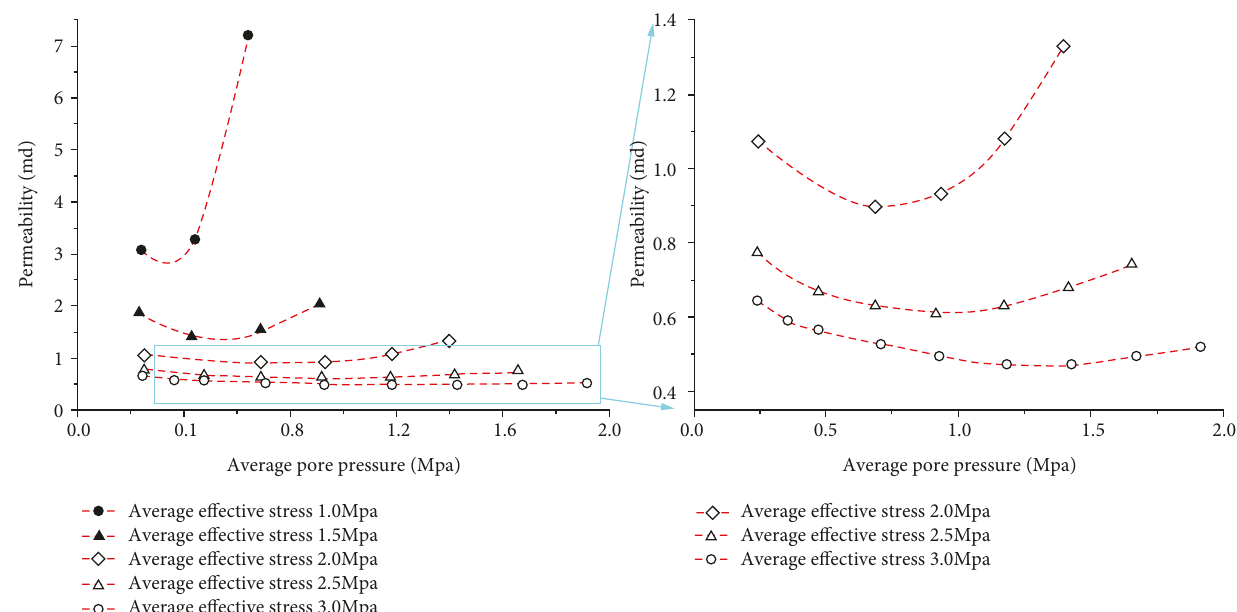
Figure 9: Test results on the pore pressure seepage under constant average e ff ective